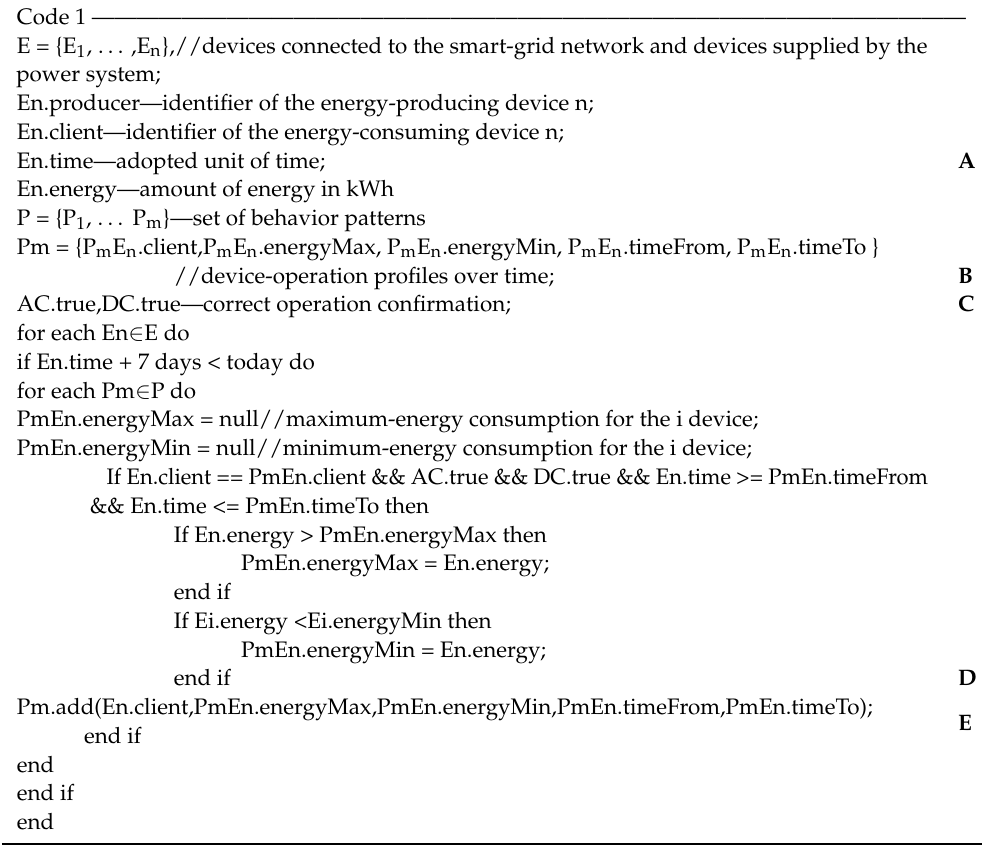
Algorithm 1. Simplified algorithm for a profiling